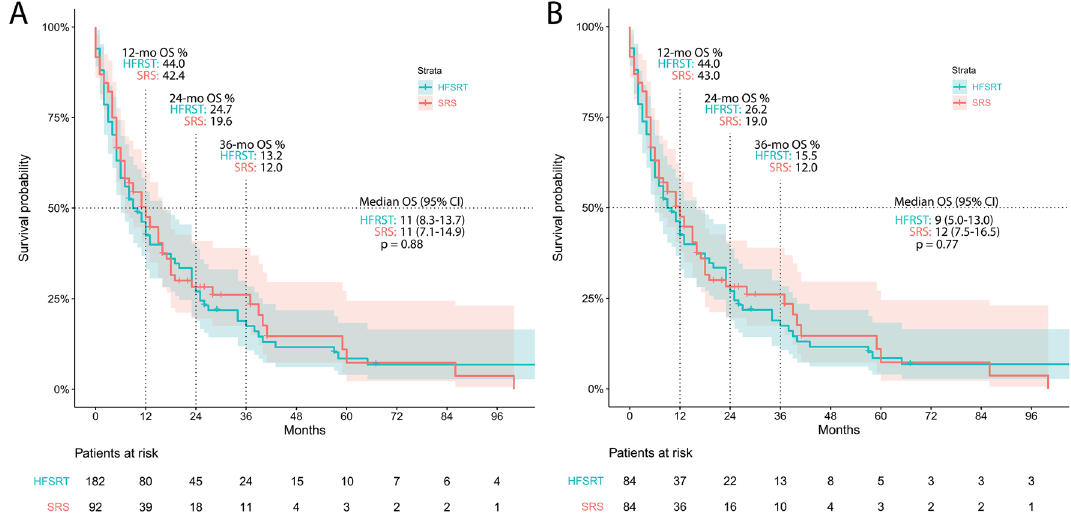
Figure 1. Kaplan–Meier analysis of survival by treatment technique before ( A ) and after ( B ) propensity score matching.